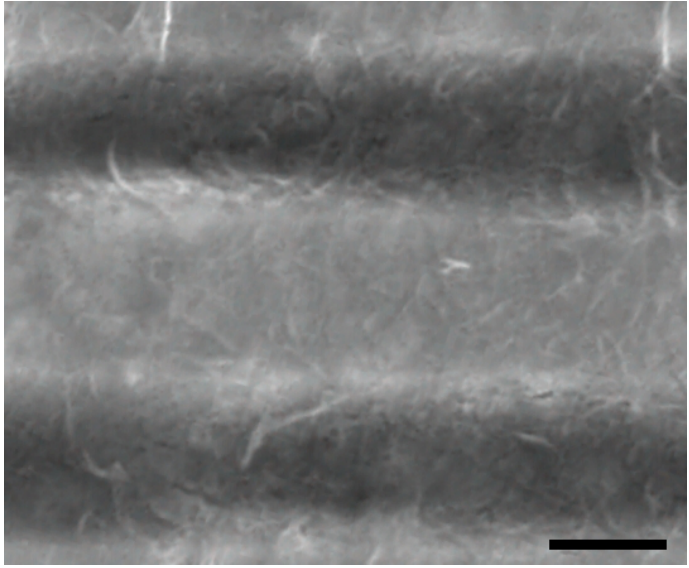
Figure 4. SEM micrography of SWCNTs deposited between electrodes. Scale bar: 1 